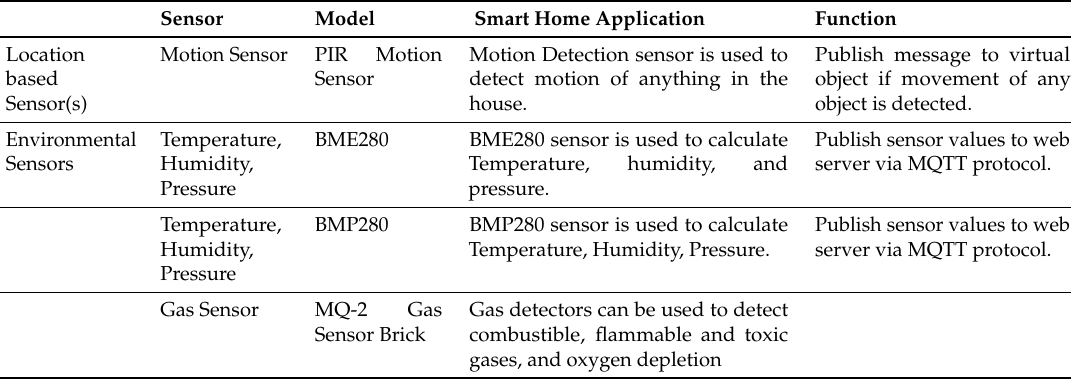
Table 3. Detail Information of Sensors used in experimental setup.